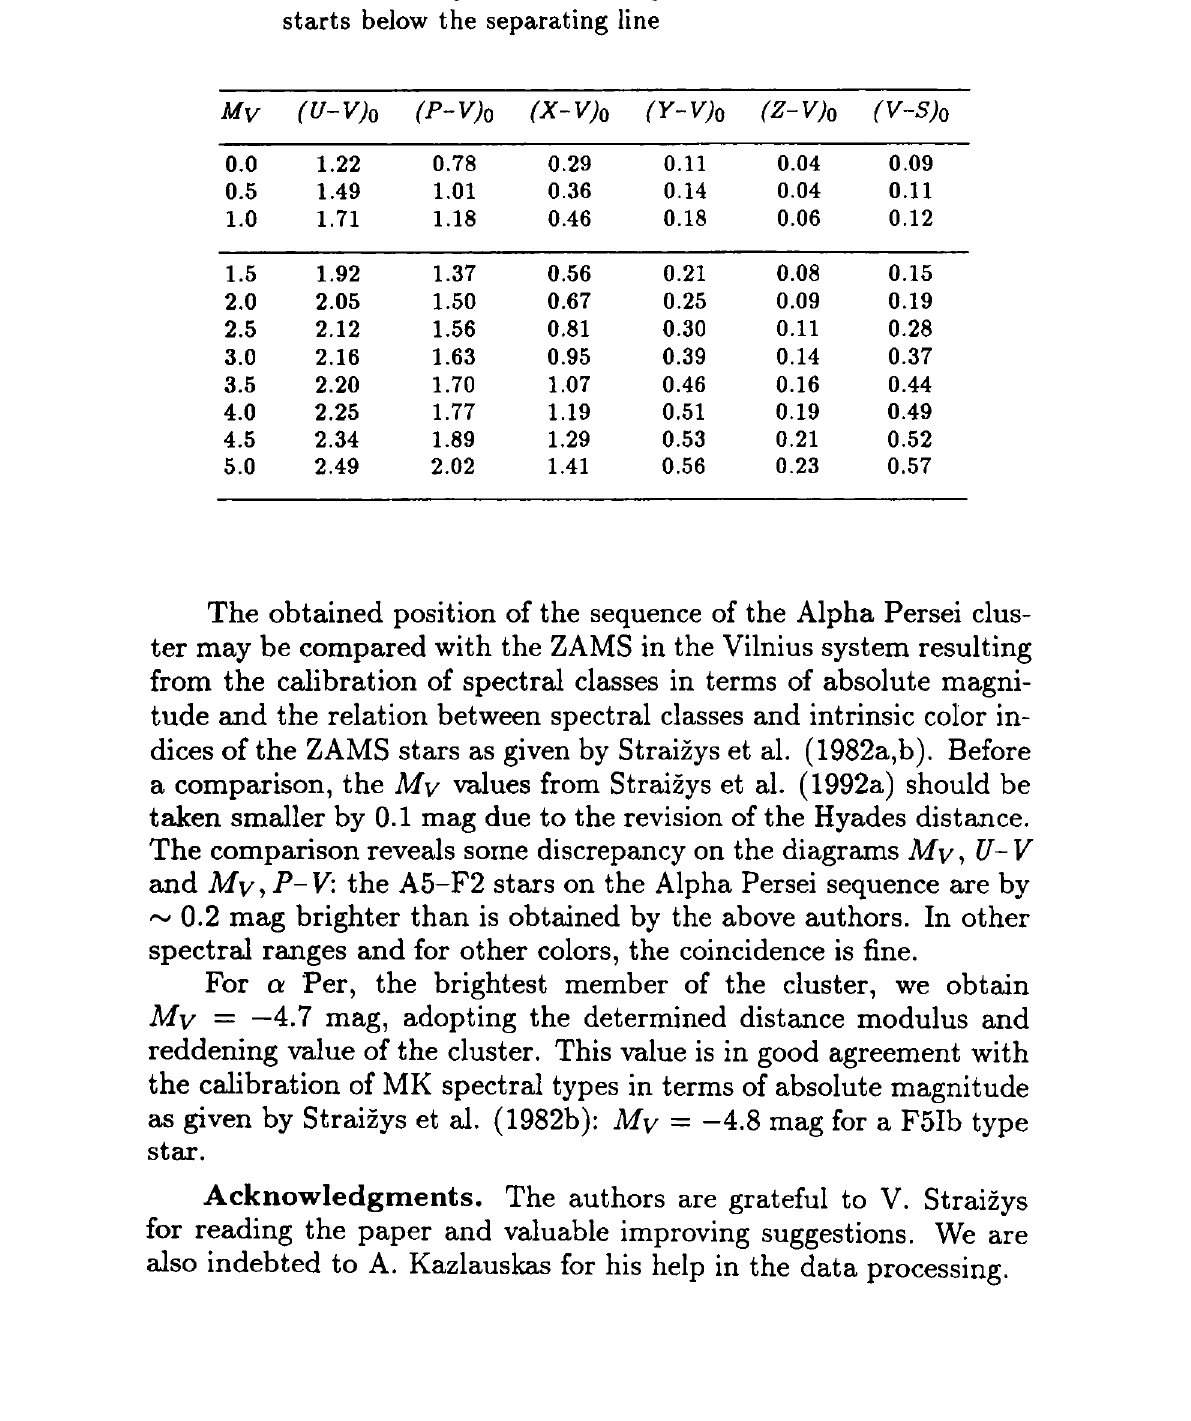
Table 3. The main sequence of the Alpha Persei cluster. The ZAMS starts below the separating